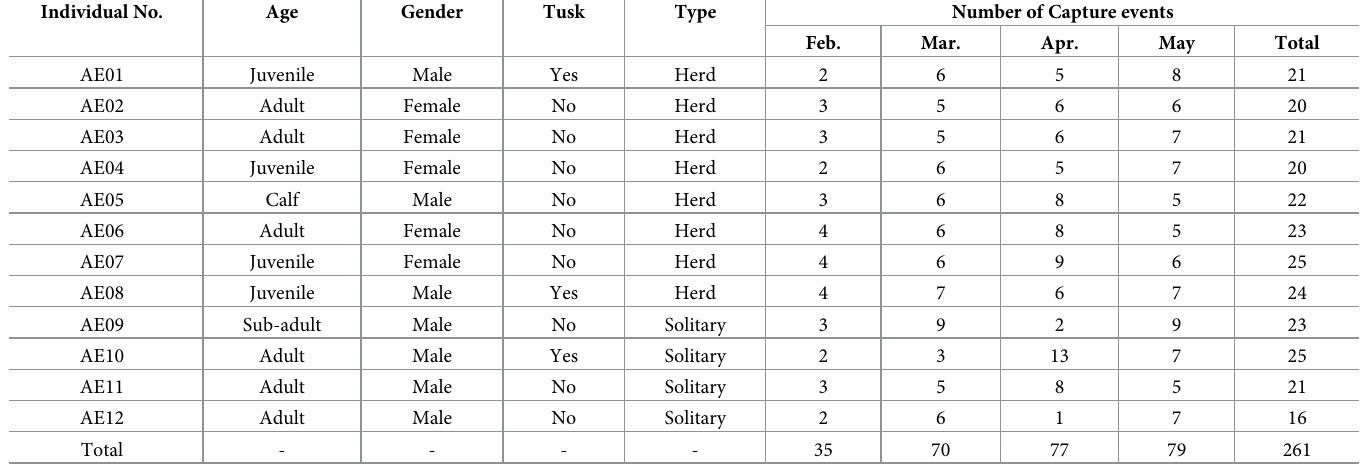
Table 3. Number of capture events per individual per month. Individual